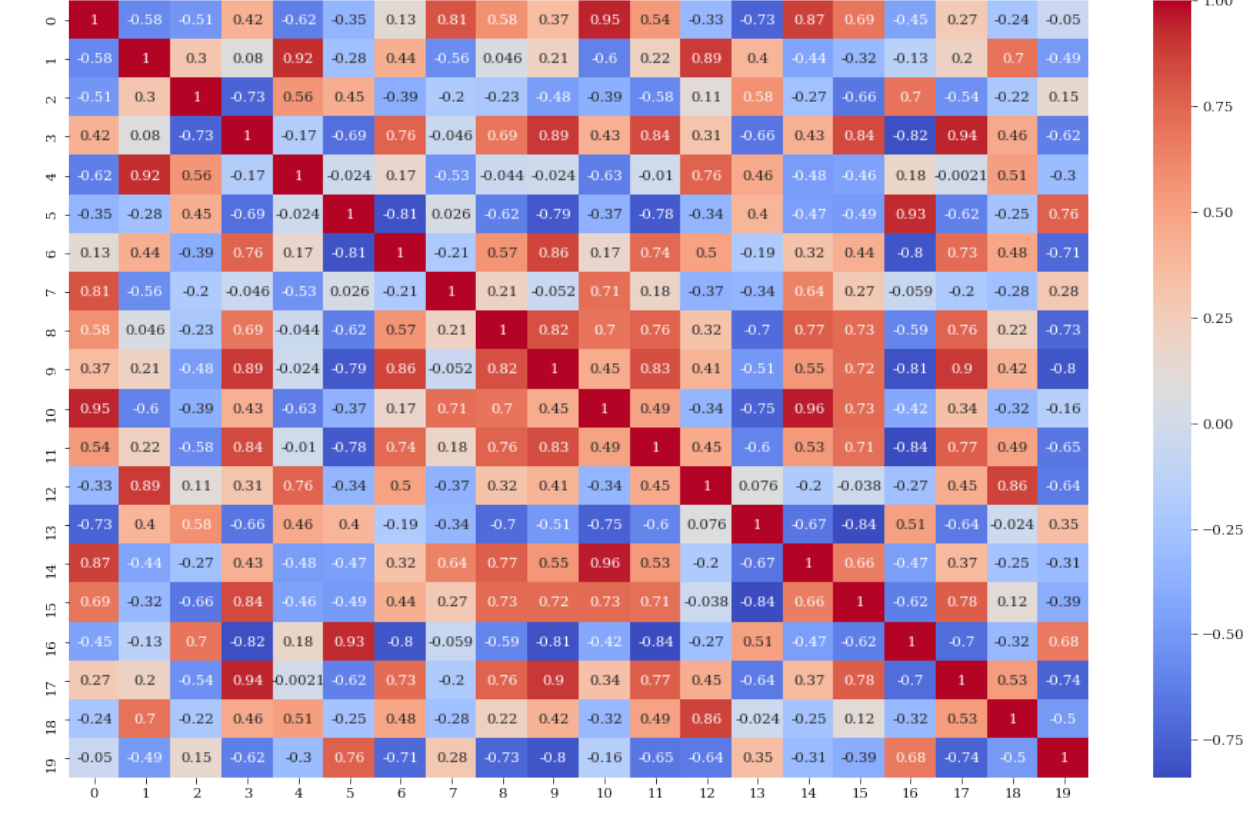
Figure 7. Correlation matrix of the high-level